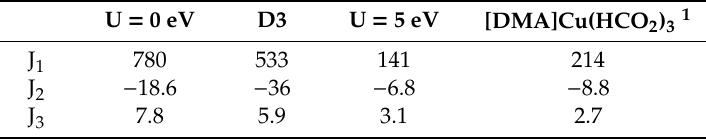
Table 1. Spin exchange interactions (in K) for H = 1/2 ∑ ij J ij S i S j , with S = 1/2, calculated with GGA, GGA+U, GGA+D3(BJ), and comparison with another quasi-1D Cu MOF. U = 0 eV